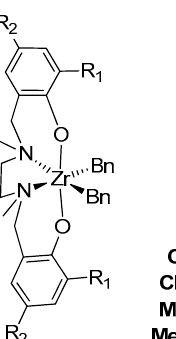
Figure 1. Diamine-bis(phenolate) Zr-complexes R 1 R 2 (Bn = benzyl).